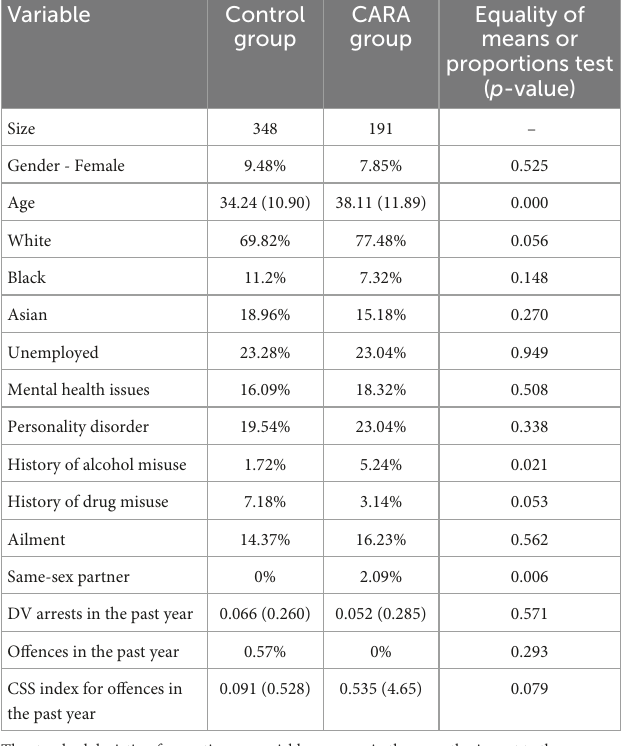
TABLE 2 West Midlands Police Data Descriptive Statistics - Means of general offender